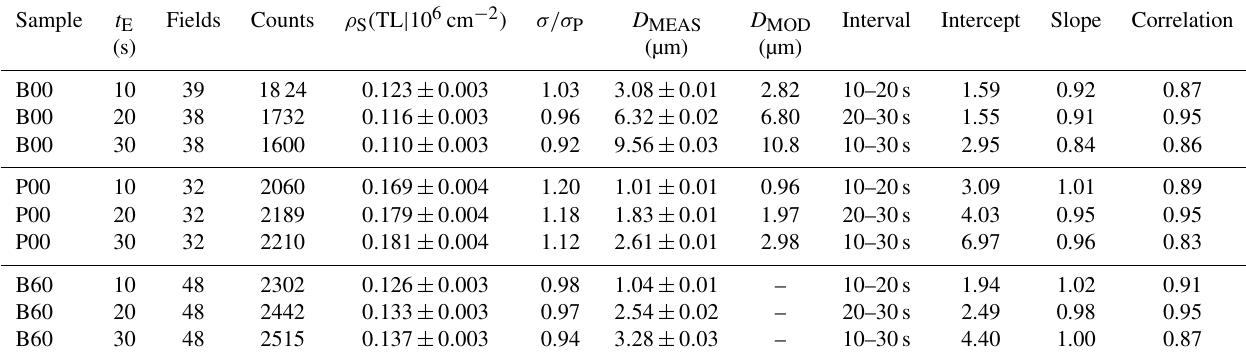
Table 1. Repeat track counts and measured track openings in a basal face (B00), prism face (P00) and an intermediate face (B60) of a Durango apatite after 10, 20 and 30s etching. Intercepts and slopes and correlation coefficients of geometric mean regression lines in Fig. 1. Detailed data in the Supplement file S2.